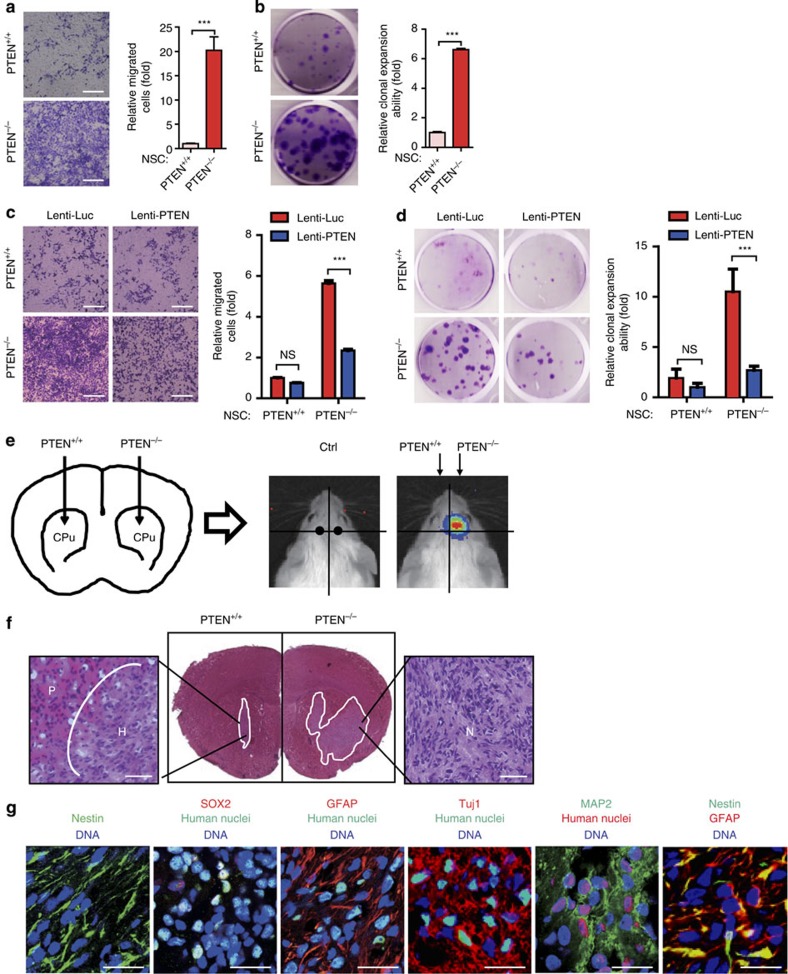
PTEN-deficient NSCs demonstrated neoplastic features in vitro and in vivo.(a) Migration abilities of WT and PTEN−/− NSCs were evaluated by Transwell assays. Relative cell migration efficiency was determined. Data are shown as mean±s.e.m. n=3. ***P<0.001 (t-test). Scale bars, 1 mm. (b) Clonal expansion analysis in WT and PTEN−/− NSCs. Crystal violet staining-positive cells were calculated and presented as fold induction using Image J. Data are shown as mean±s.e.m. n=4. ***P<0.001 (t-test). (c) Cell migration analyses of NSCs transduced with a PTEN expression vector (Lenti-PTEN) or a control vector (Lenti-Luc). Data are shown as mean±s.e.m. n=6. ***P<0.001 (t-test); NS, not significant. Scale bars, 1 mm. (d) Clonal expansion analysis of NSCs transduced with Lenti-PTEN or Lenti-Luc. Data are shown as mean±s.e.m. n=3. ***P<0.001 (t-test); NS, not significant. (e) Representative photon flux images from the brain of NOD/SCID mice implanted with WT (left) and PTEN−/− (right) NSCs expressing luciferase (also see Supplementary Fig.6a for details). Images were taken 20 min after L-luciferin was injected intraperitoneally (i.p.). n=3. (f) H&E staining and photomicrograph of a section of entire brain showing dramatic neoplastic expansion of PTEN−/− NSCs relative to WT control (2 × 106 cells per injection), 35 days after cells were injected into the contralateral corpus striatum. H represents residual human NSC graft without expansion, N represents neoplasm and P represents mouse brain parenchyma. Scale bars, 500 μm. (g) Immunostaining of brain sections described in f with antibodies against the indicated antigens. Human nuclei, human nucleus antigen. DNA was stained with Hoechst 33342. Scale bars, 25 μm.